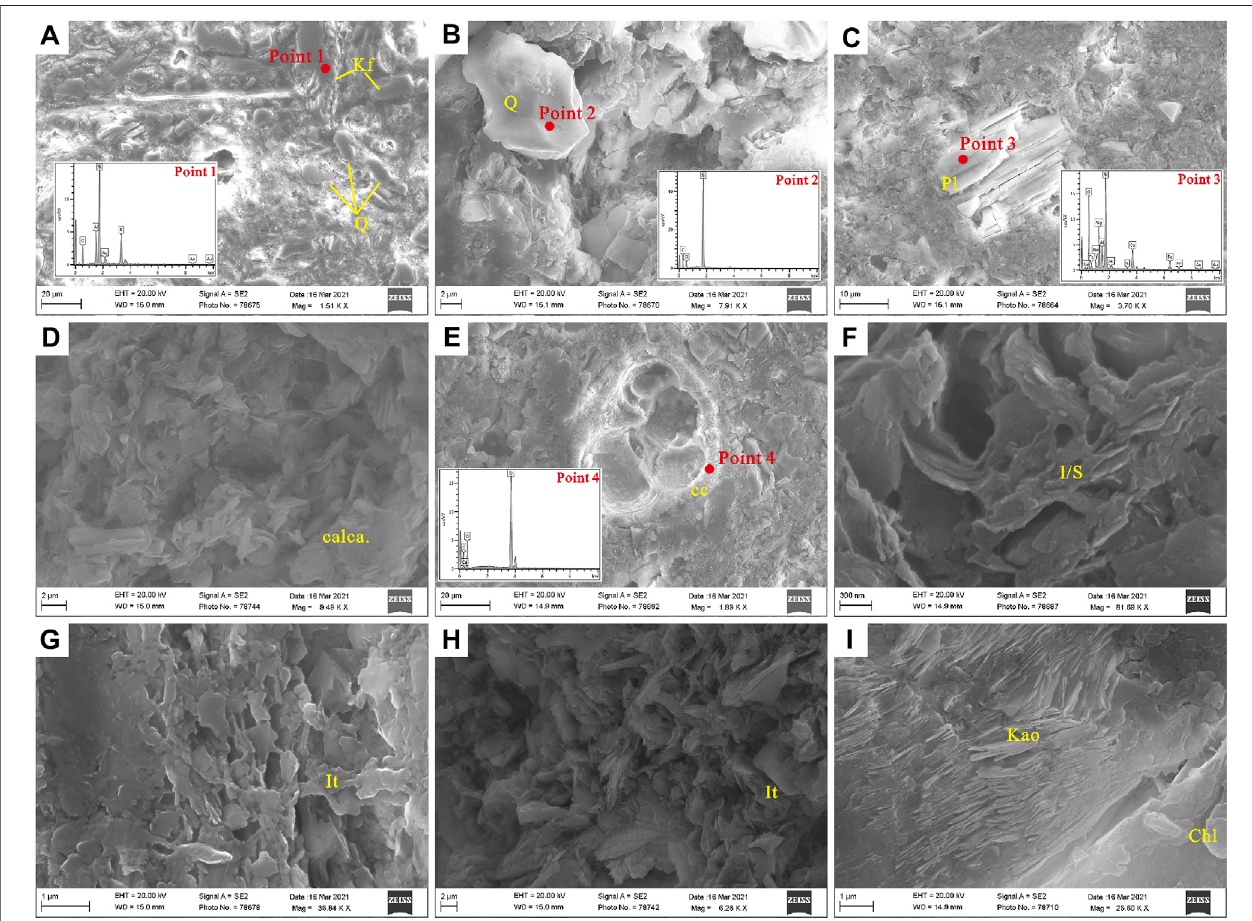
FIGURE 4 | The microstructure features of gas hydrate-bearing sediments. (A) Site W19, 126.60 mbsf, sediments consist of quartz, K-feldspar and clay minerals; (B) SiteW19,135.60mbsf,thequartzinsediments; (C) SiteW19,SiteW19,135.60mbsf,theplagioclaseinsediments; (D) SiteW19,127.80mbsf,thecalcareousultra- microfossils in sediments; (E) Site W19, 135.90 mbsf, the foraminifera shell composed of calcite; (F) Site W19, 130.20 mbsf, the I/S in sediments; (G) Site W19, 136.1 mbsf, the fi lamentous ilite in sediments; (H) Site W19, 136.1 mbsf, the fl akyilite in sediments; (I) Site W19, 166.6 mbsf, the sheet-likekaolinite and fl akychlorite. Q, kf, Pl, calca, cc, I/S, It, Kao, and Chl are short for quartz, K-feldspar, plagioclase, calcareous ultramicrofossils, calcite, illite/semectite, illite, kaolinite and chlorite, respectively.